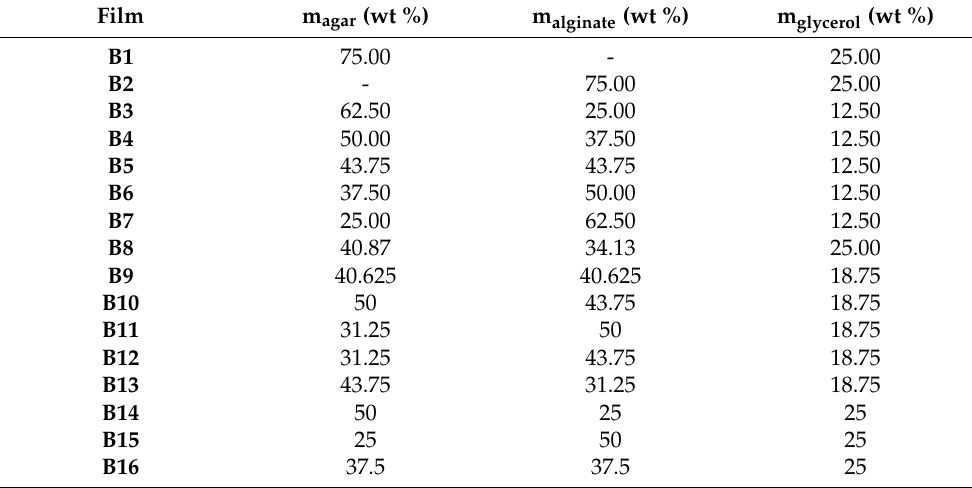
Table 1. The composition of biopolymer-based edible